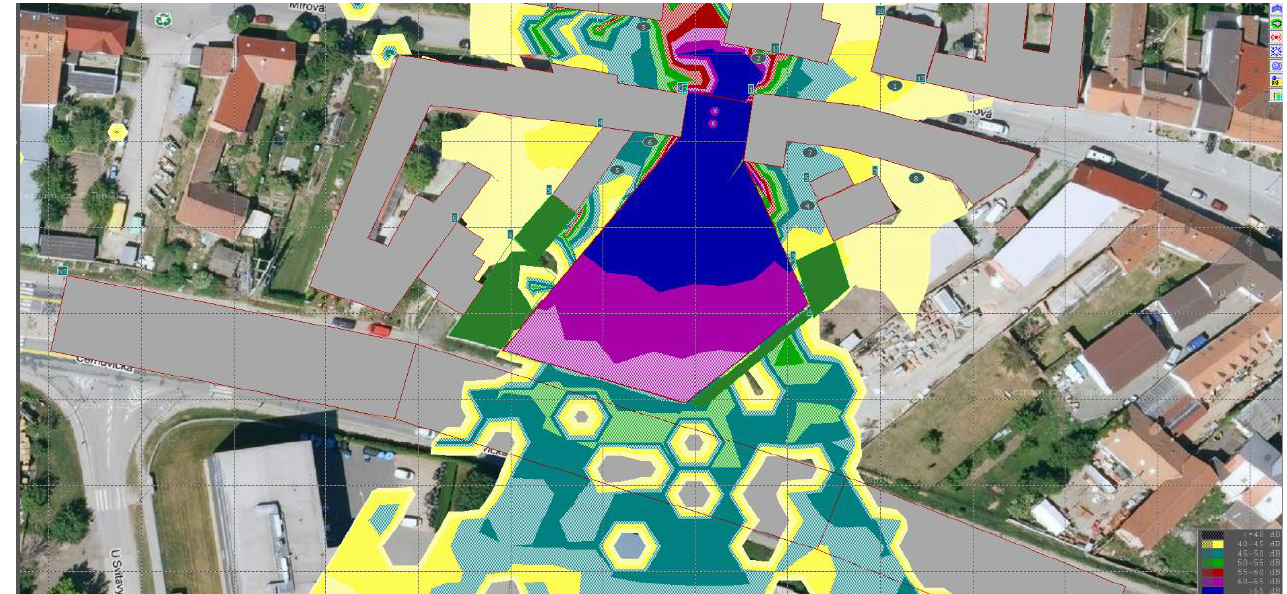
Figure 17. Colour map of isophone bands after considering acoustically significant elements with construction site fencing and a solid gate for the concreting of foundations in the investigated area, with the position of machines inside the construction site. Table 20. Table of points from the calculation of measured points for the concreting of foundations with construction site fencing and a solid gate in the investigated area, with the position of machines inside the construction site.